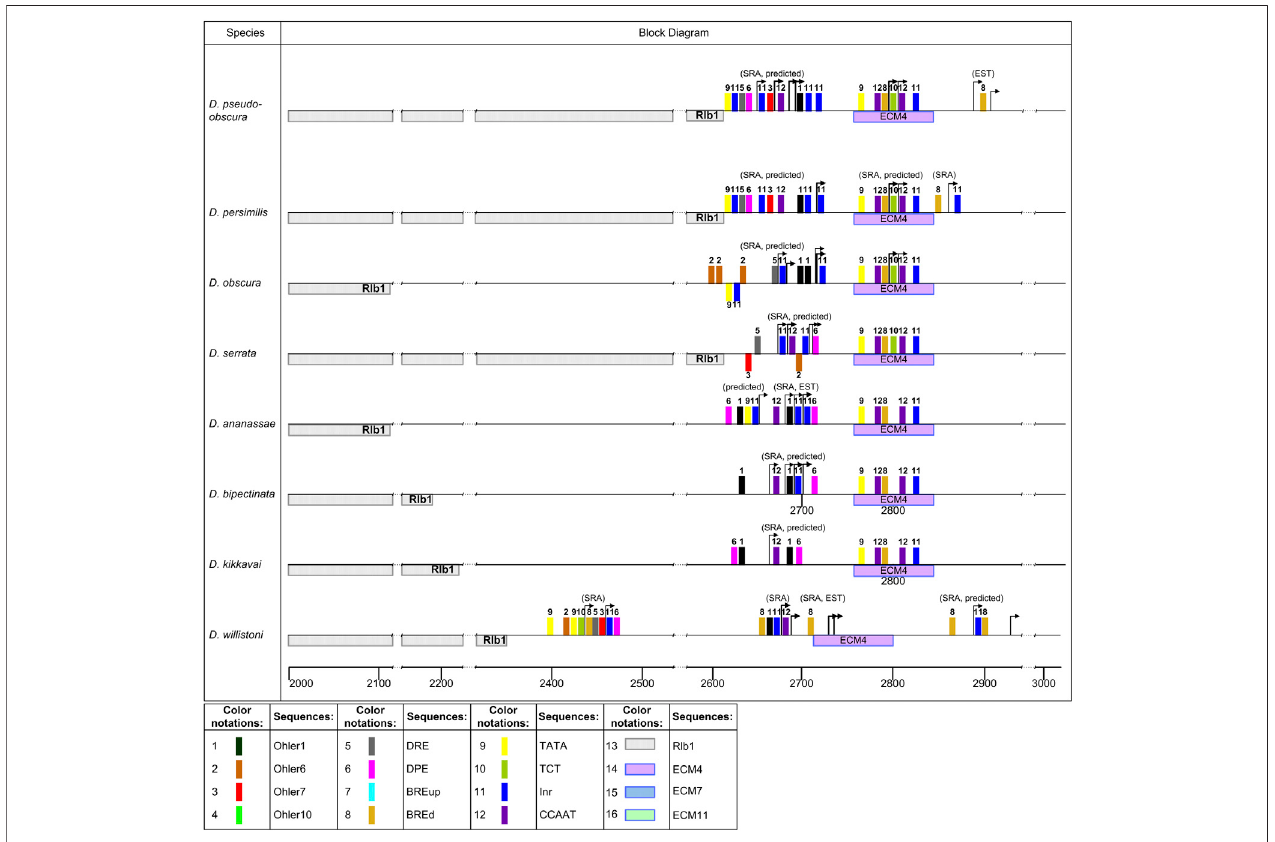
FIGURE 8 | Distribution of the elements in the promoter region in the obscura, montium, ananassae , willistoni groups. Designations as in Figure 7 .